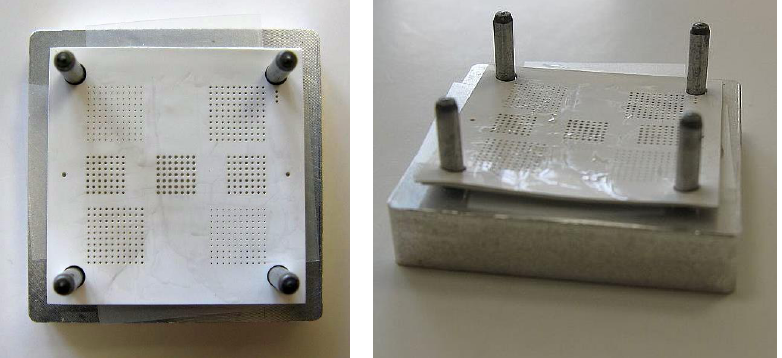
Figure 2. Stacking of three layers onto an alignment fixture, in this case, using hydroxyethyl cellulose